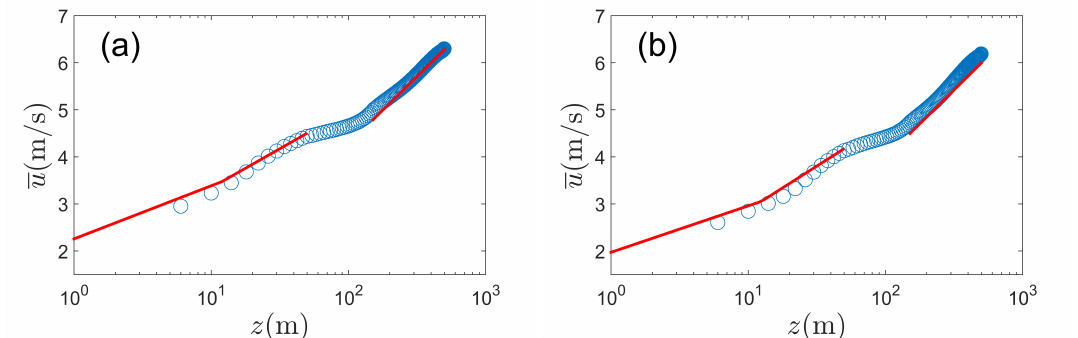
Figure 8. Predicted and simulated areally averaged boundary-layer velocity profiles for an infinite wind farm showing distinct logarithmic regions: ( a ) S x = 6, h = 12 m; ( b ) S x = 6, h = 20 m. Blue markers indicate LES data, and red lines indicate boundary-layer